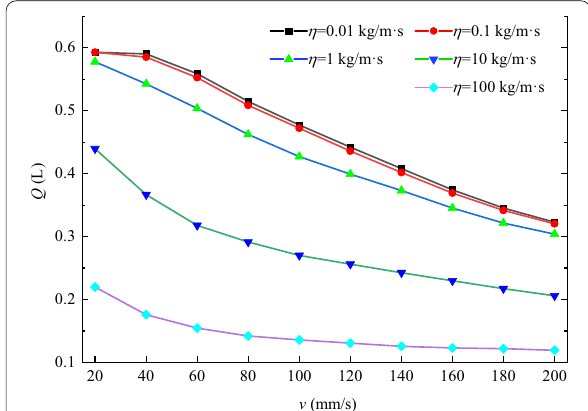
Figure 10 The influence curve of the penetration velocity on the coring volume